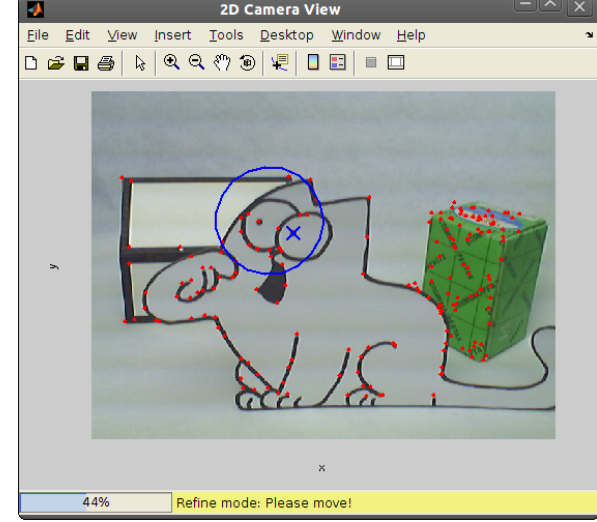
(a) Camera view in refine mode. Red dots show inaccurate scene points. The blue cross highlights the points to be focused on right now (pupil of